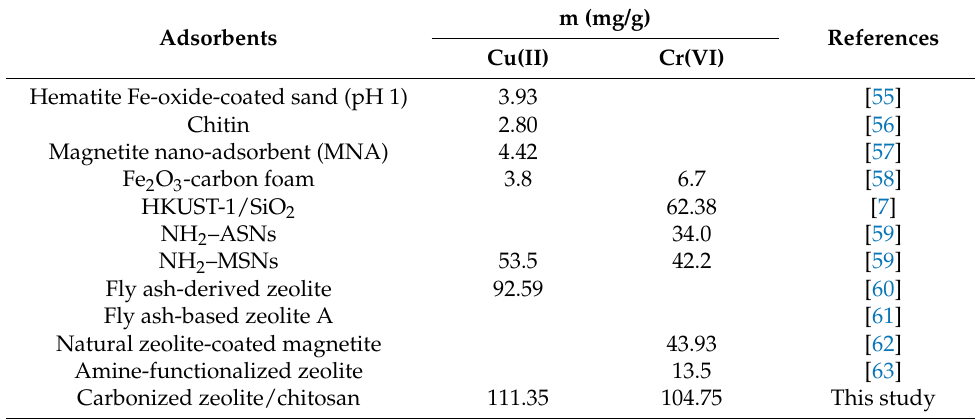
Table 3. Comparison with other adsorbents.